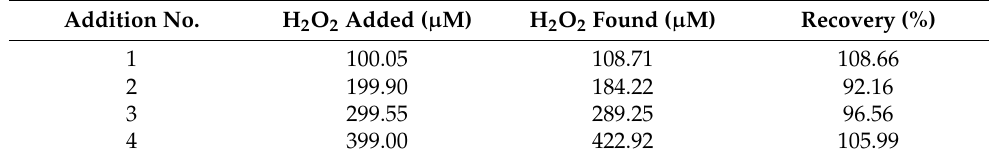
Table 2. Determination of H 2 O 2 in Tap Water.